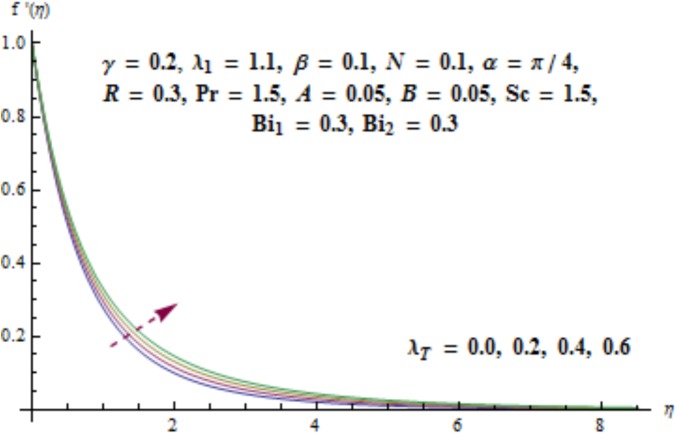
Behavior of λT on f'(η).